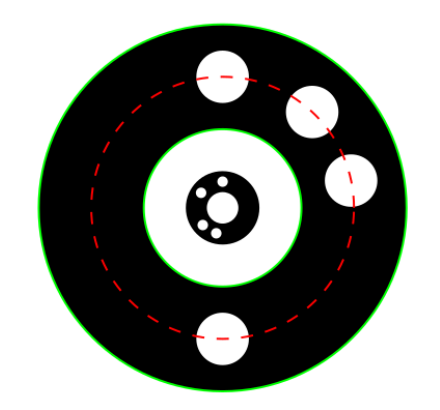
Figure 2: The optical target used in this work. The target code is obtained sampling on the red dashed line.